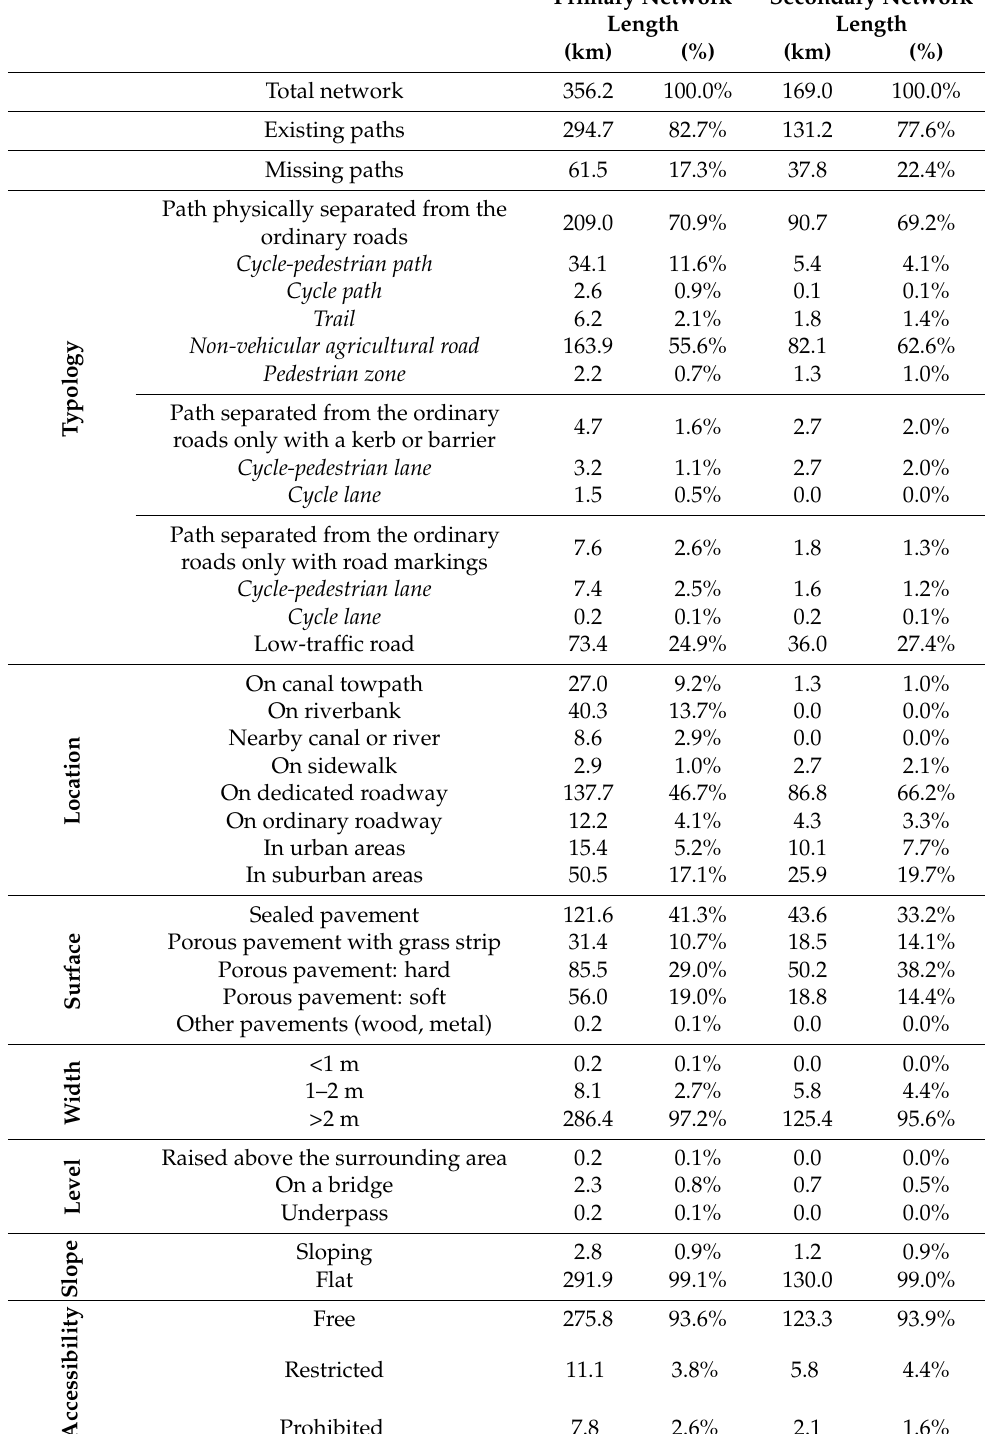
Table 5. Characteristics of the proposed soft mobility